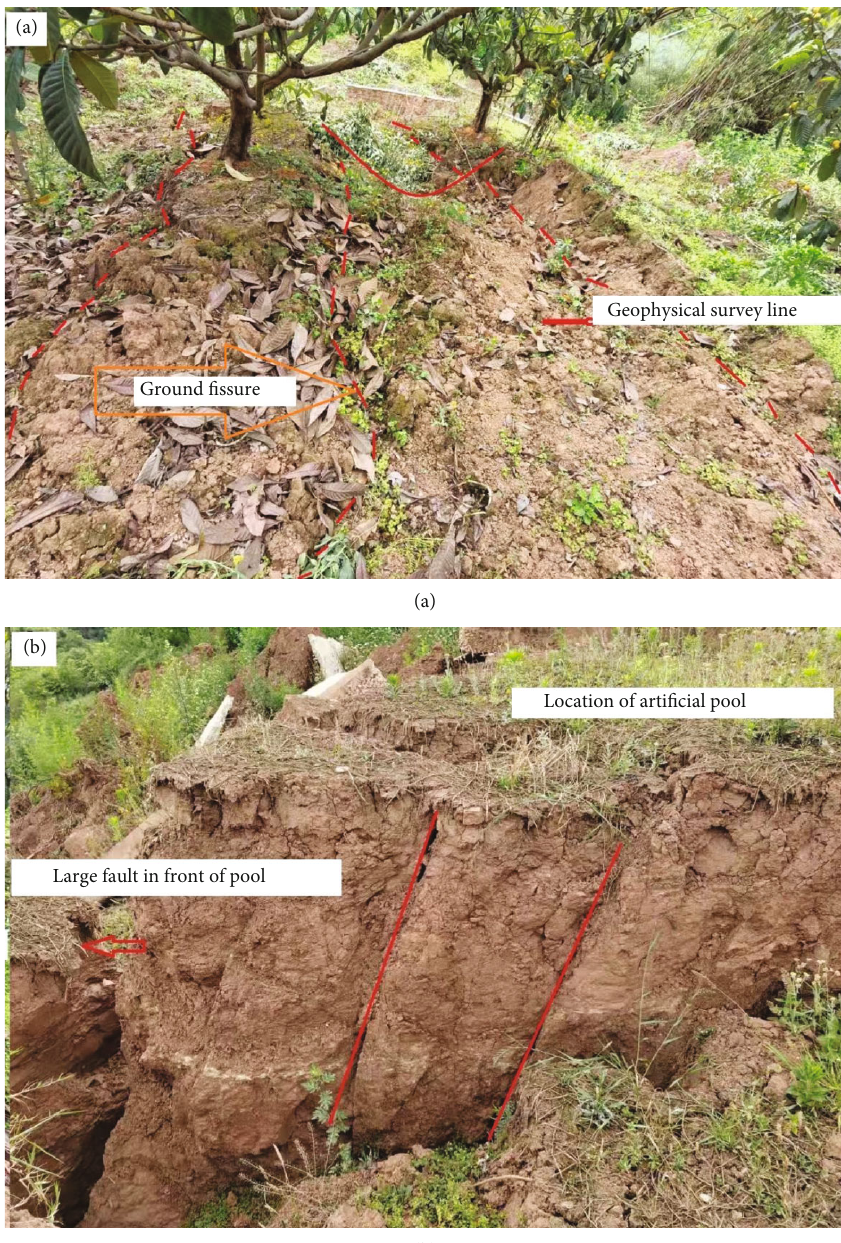
Figure 9: Land subsidence and cracks. (a) A large number of settlement and fi ssure areas throughout the loquat forest land on the northeast side of the landslide. (b) An inclined fi ssure at the bottom of the